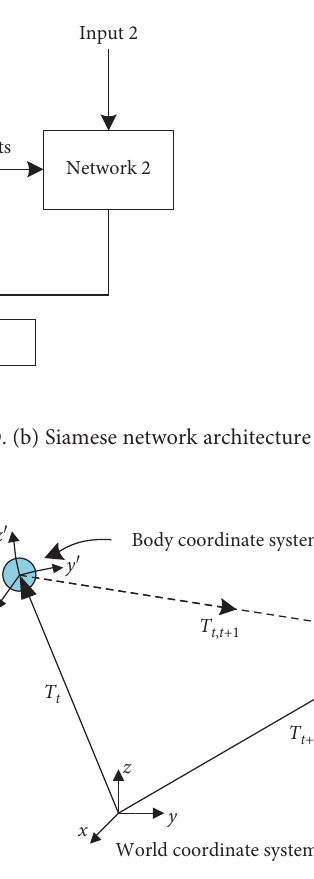
Figure 3: Relative poses of consecutive image